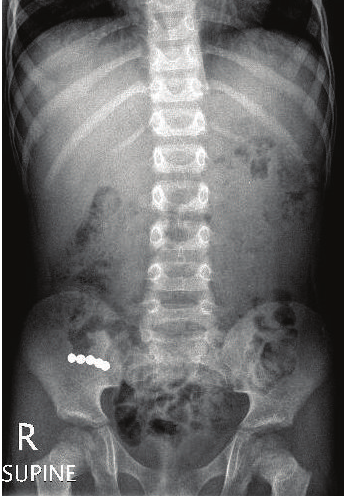
Figure 3: Plain X-ray of abdomen of 4-year-old boy showing ingested 5 pieces of rare-earth magnets joined together due to strong magnetic